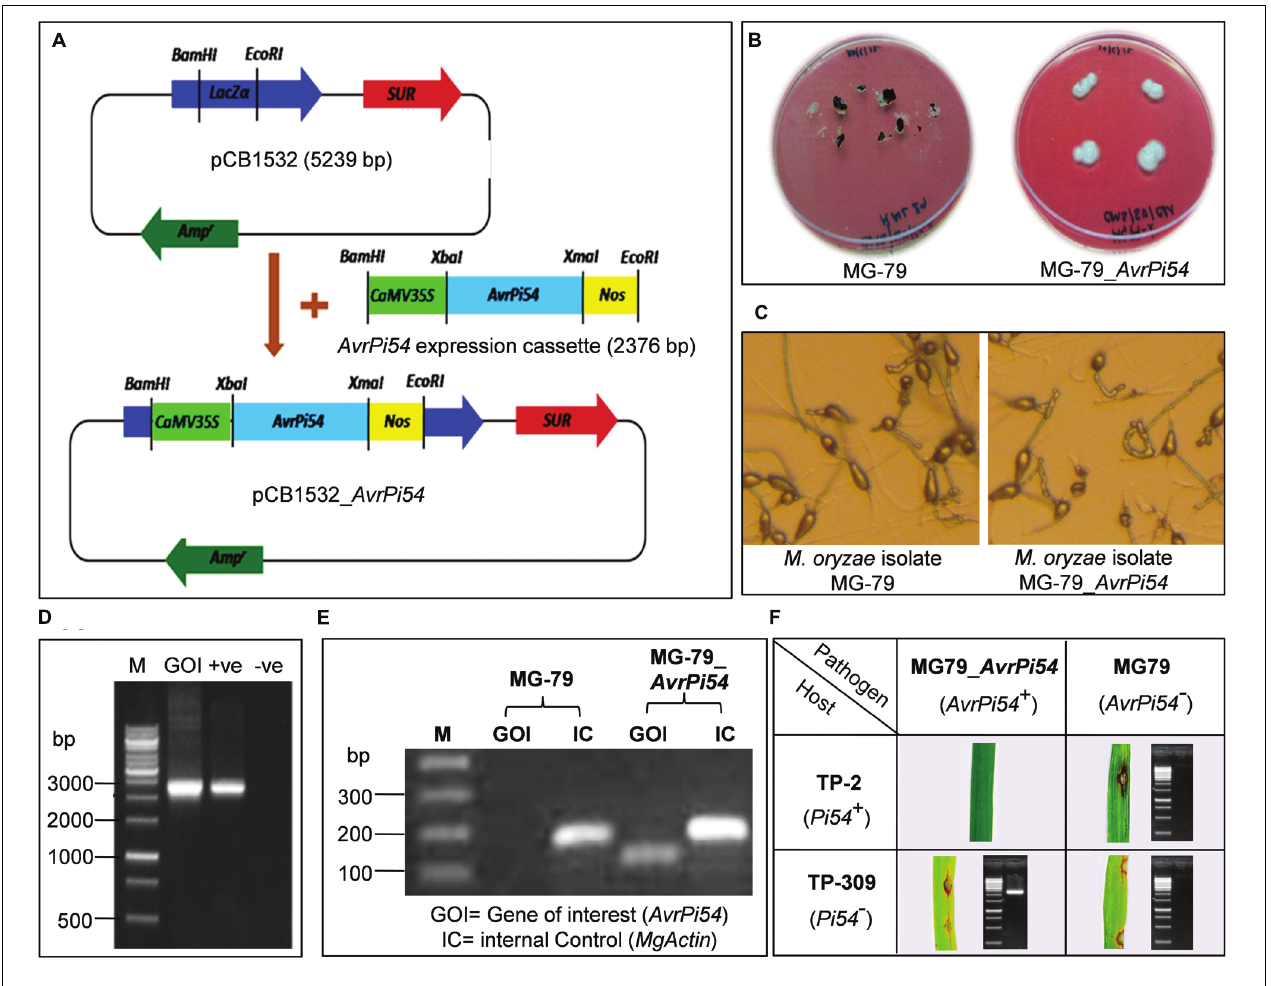
FIGURE 4 | Validation of avirulence function of AvrPi54 gene by complementation test. AvrPi54 expression cassette (2376 bp) was cloned in the Bam HI- Eco RI site of fungal transformation vector pCB1532 (5239 bp) to produce pCB1532_AvrPi54 (A) . After 10 days the non-transgenic control (MG-79) showed symptoms of withering but the transgenic fungus grew (MG-79_ AvrPi54 ) normally (B) . Microscopic analysis revealed no significant morphological differences between transgenic and non-transgenic isolates (C) . To further confirm the success of transformation, AvrPi54 expression cassette (EC, 2376 bp) was amplified from genomic DNA of transgenic isolate MG-79_ AvrPi54 (). pCB1532_ AvrPi54 plasmid DNA ( + ve) and genomic DNA of non-transgenic isolate MG-79 ( − ve) were used as template used as templates which served as positive and negative controls, respectively (D) . Semiquantitative RT-PCR analysis shows the expression of the AvrPi54 gene in transgenic isolate (102 bp target amplicon) but not in non-transgenic. M. oryzae Actin gene (housekeeping gene) was used as internal control (175 bp amplicon) for this experiment (E) . Complementation of avirulence function was tested by inoculating 15 days old seedlings of TP-309 (rice line that do not contain Pi54 gene) and TP-2 (transgenic rice line that contain Pi54 gene in TP-309 background) with M. oryzae strains MG-79 and MG-79_AvrPi54 (F)